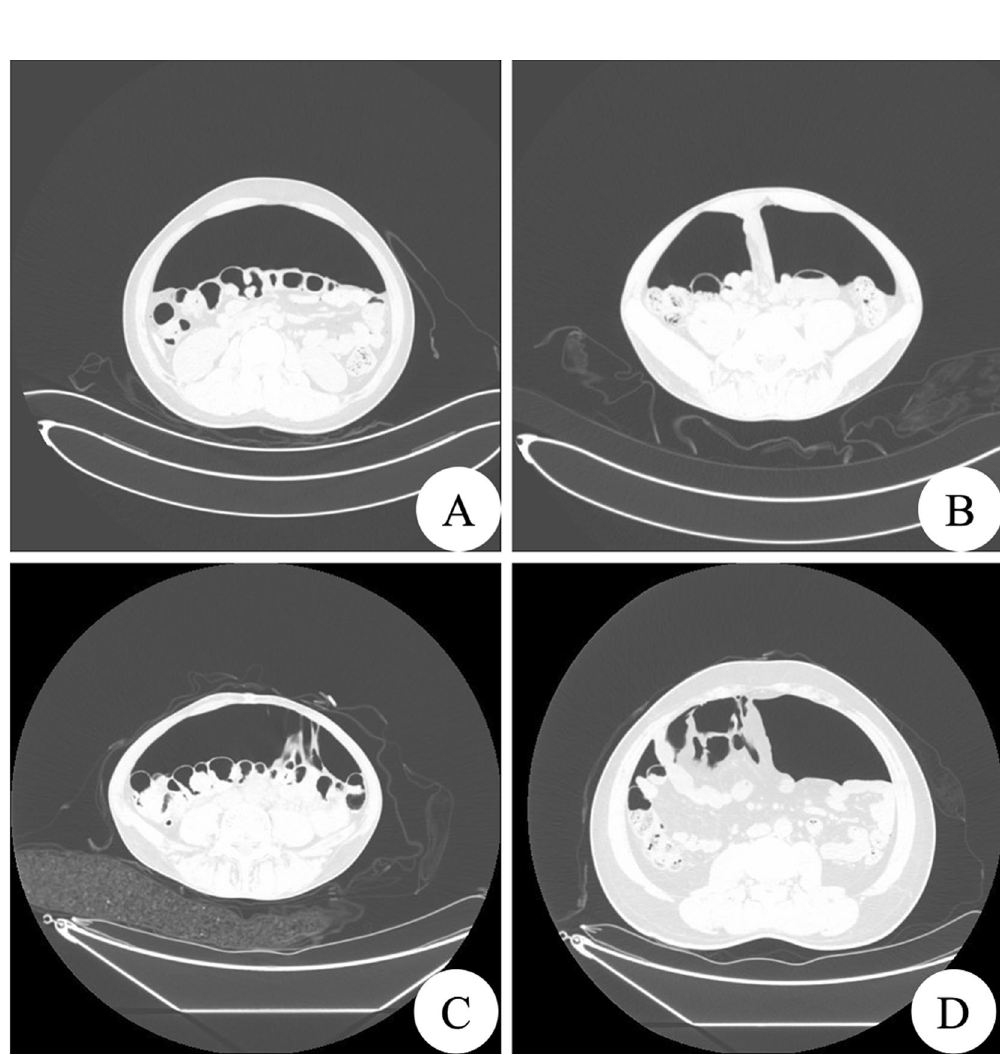
Figure 4. Image of the graded diagnosis of intestinal adhesions on CT with pneumoperitoneum. ( A ) Shows the CT image of the abdomen after pneumoperitoneum as level 0. ( B ) Shows the CT grade diagnosis of pneumoperitoneum as level 1. There is a single point adhesion between the local small bowel tube and the anterior abdominal wall. ( C ) Shows that the CT classification of pneumoperitoneum is level 2, showing that part of the intestinal tube and omentum tissue has multiple adhesions to the anterior abdominal wall. ( D ) Shows that the CT classification of pneumoperitoneum is level 3, and some diffuse adhesions of the anterior abdominal wall of the intestine and omentum tissue can be